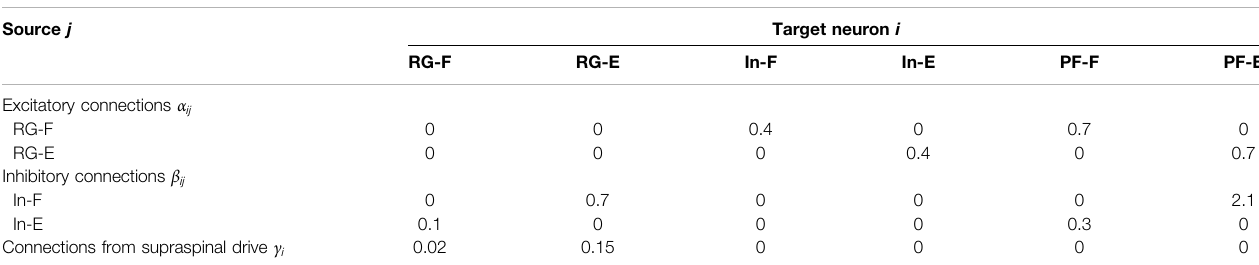
TABLE 1 | Parameters for synaptic connections.